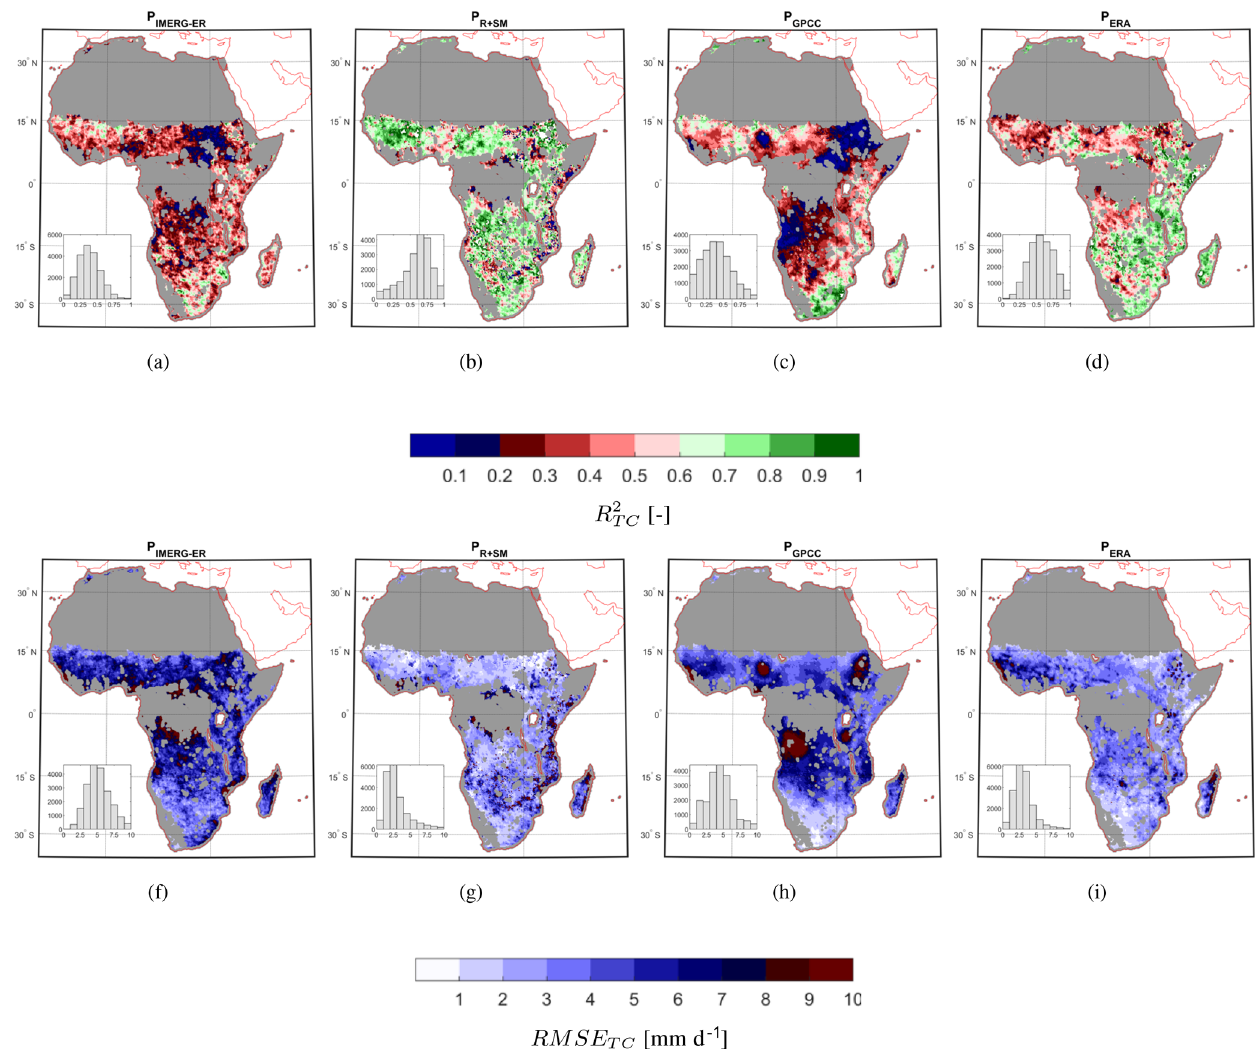
Figure 9. Triple-collocation squared correlation ( R 2 ; panels a, d ) and root mean square error (RMSE TC ; panels f, i ) in millimetres per day TC for IMERG Early Run (IMERG-ER; panels a and f ), the integrated product (IMERG Early Run and SM2RAIN applied to ASCAT, SMAP and SMOS; P R + SM ; panels b, g ), the Global Precipitation Climatology Center product (GPCC; c, h ) and the reanalysis product ERA5 (ERA5, d, i ). Grey areas represent the committed area of ASCAT which we excluded from the analysis. The results refer to the validation period (i.e. 2018). Grey areas represent the masked areas based on what is described in Sect.